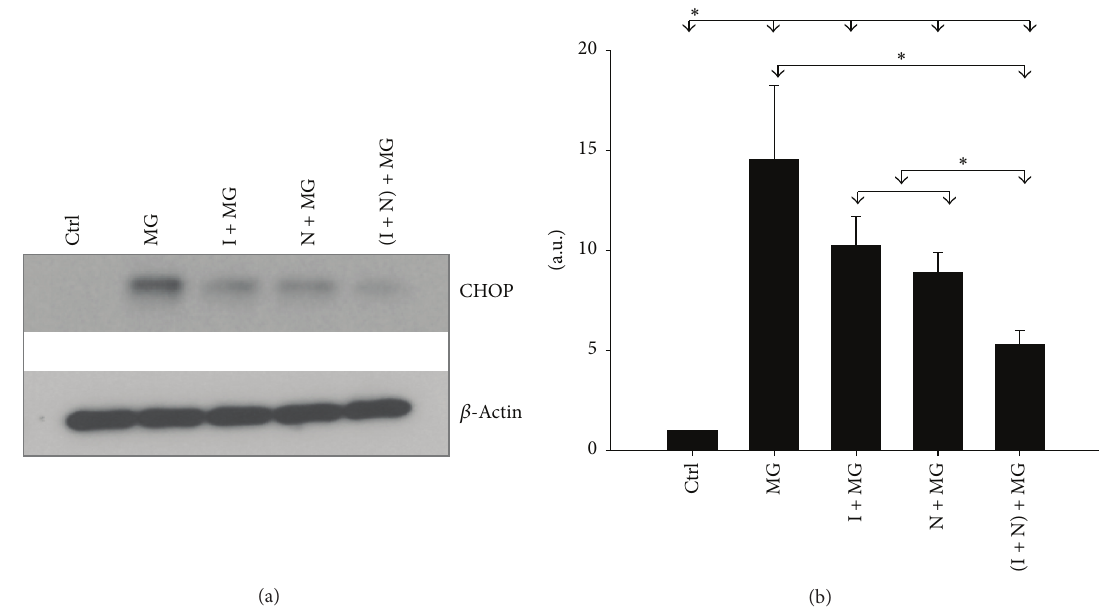
Figure 5: Pretreatment with IGF-1 and NAC represses MG132 induced ER stress. The cells were pretreated with IGF-1 and NAC, alone or together, for 18h, followed by addition of MG132 (5 𝜇 M) for 24 h. (a) Western blot analysis for CHOP (an ER stress marker). Data are representative of three separate experiments. (b) Densitometric analysis of CHOP from three independent experiments. Level of significance is denoted as ∗ 𝑝 ≤ 0.05